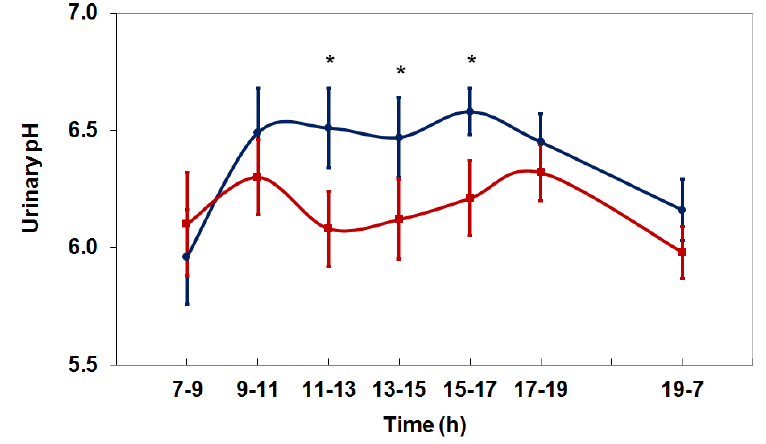
Figure 1. Diurnal variation in urinary pH during a 24-h period in healthy individuals under controlled, standardized conditions before (control, blue line) and after receiving 1500 mg/day L -methionine (red line) (M ± SEM) (* p < 0.05) [31].